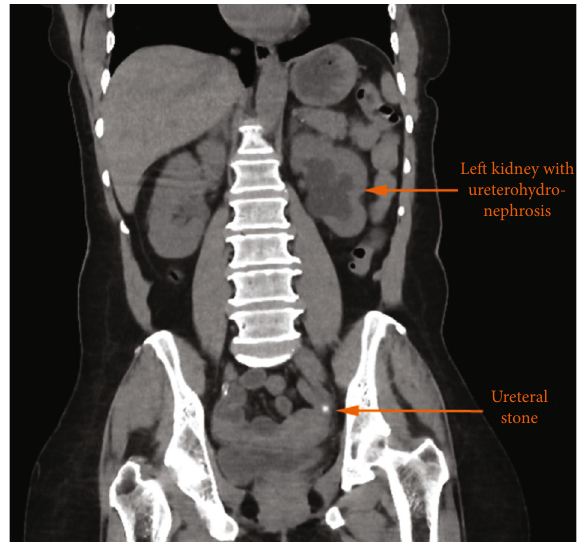
Figure 1: Abdominal computed tomography showing a hypotrophic left kidney with ureterohydronephrosis and a ureteral